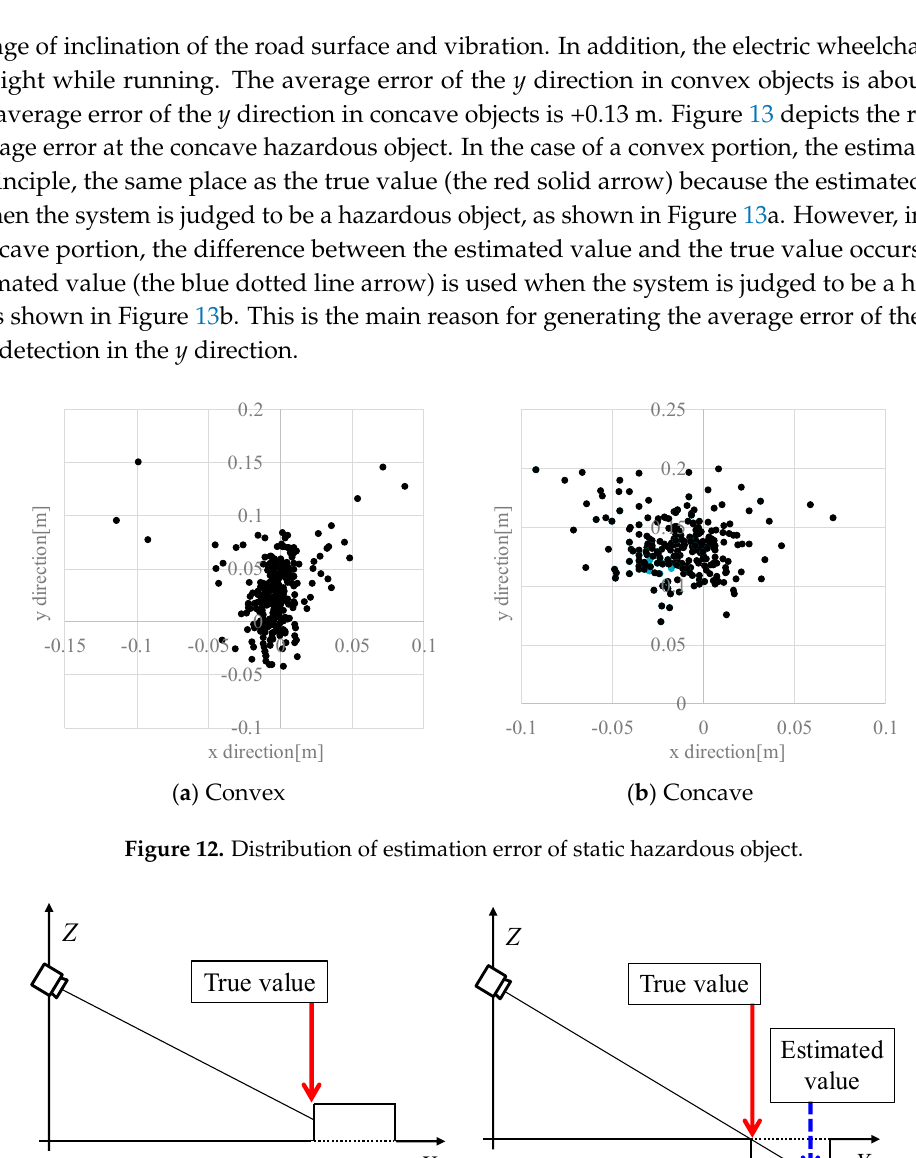
Table 4. Detection rate of dynamic hazardous objects in the front direction (nighttime).